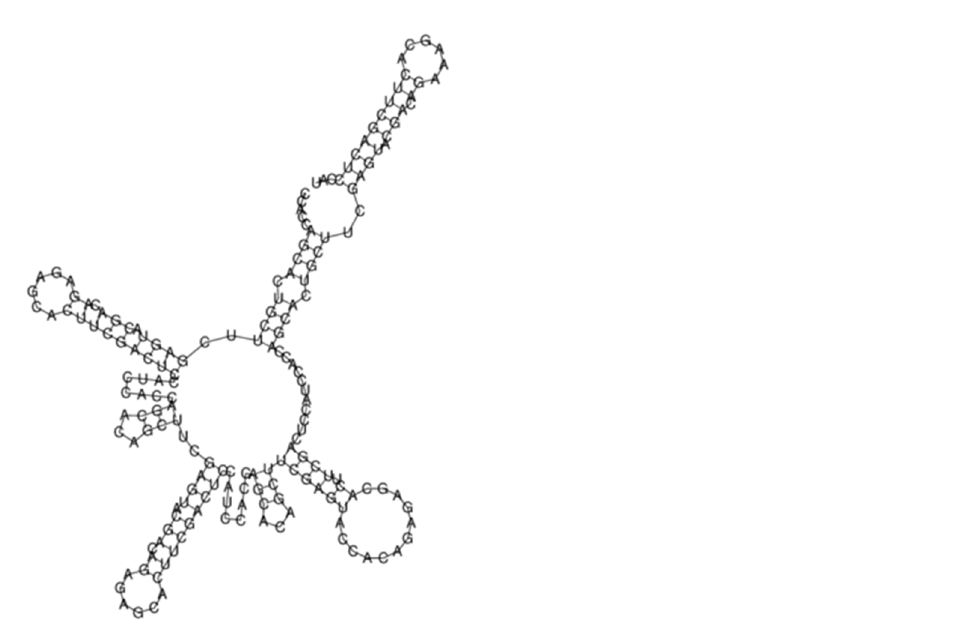
Figure 5. Simulated structure of five repeats of the satellite at position X:17441768, calculated with the RNAfold program [22].